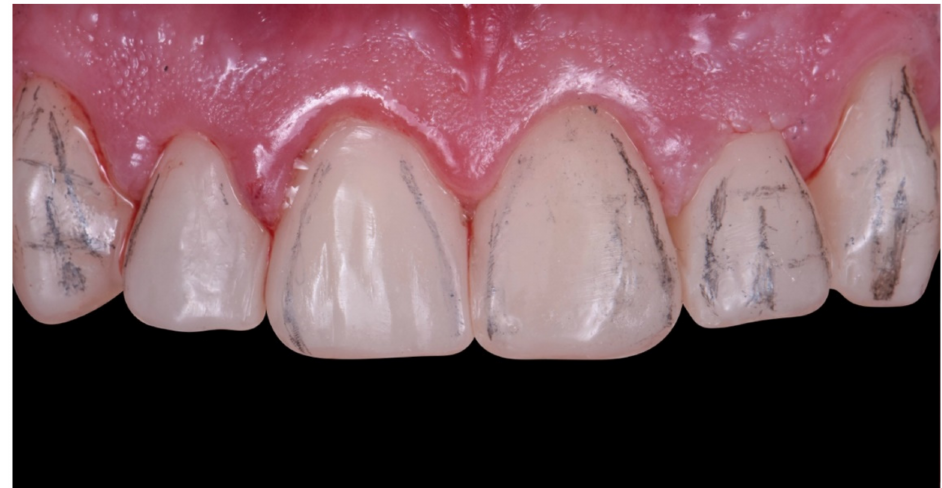
Figure 26. Finishing and polishing of the anterior